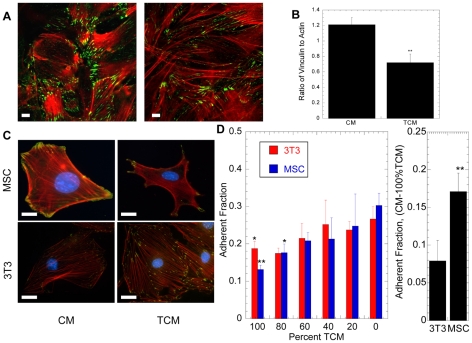
Changes in the distribution and strength of focal adhesions.Confocal micrographs (A) of 24-hour CM- (left) and TCM- (right) treated MSCs stained with Phalloidin (F-actin, red), and anti-vinculin (green). The vinculin to actin ratios quantified from confocal images (B) demonstrated a reduced concentration of focal adhesion proteins in TCM-treated MSCs. Epifluorescent microscopy was used to further investigate the effect of TCM on focal adhesion distribution in MSCs and 3T3 fibroblasts (C). CM-treated MSCs displayed a brush-like pattern of focal adhesions; whereas, focal adhesion on TCM-treated cells appeared as points at the end of cytoskeletal extensions. TCM-treatment had no effect on the pattern of focal adhesions on 3T3 cells. A centrifuge-based adhesion assay was used to determine the effects of TCM-treatment on the adhesion of MSCs and 3T3 fibroblasts (D). TCM treatment resulted in a reduced fraction of adherent cells in a dose-dependent manner for both cell type (left), but significantly more for MSCs (right). (scale bars = 10 µm)